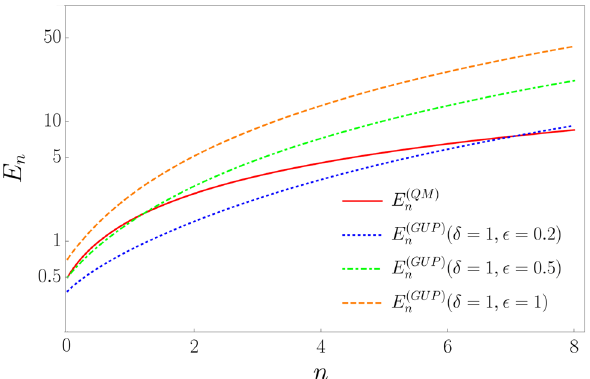
Fig. 1 Energy spectrum as a function of the level number n . We have set for simplicity ¯ h = m = ω = 1. The log-scale has been used on the vertical